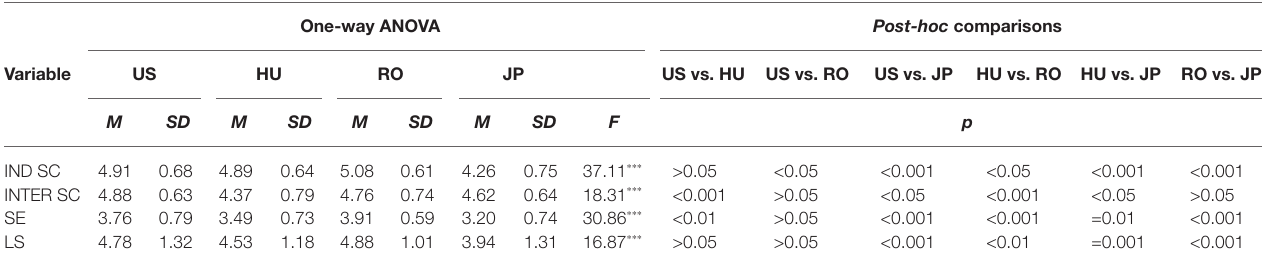
TABLE 2 | Results of one-way ANOVA with post-hoc comparisons between the four cultural groups for the variables in the Study 1 model.